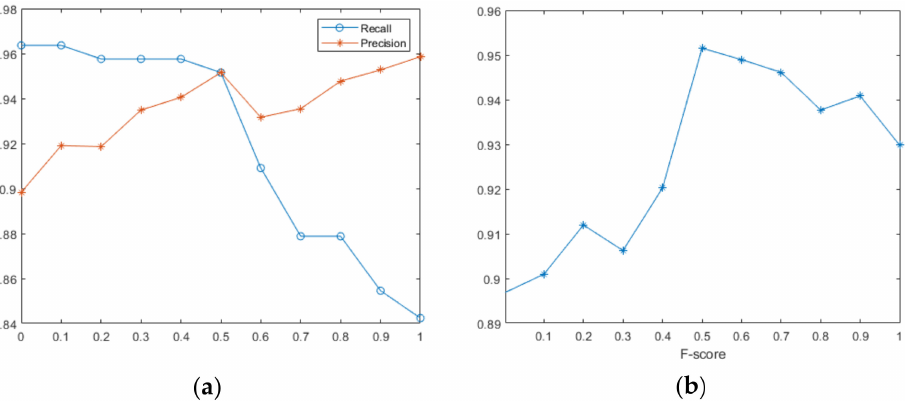
Figure 8. Performance of Recall, Precision, and F-score with different d k . ( a ) Recall and Precision. ( b ) F-score.